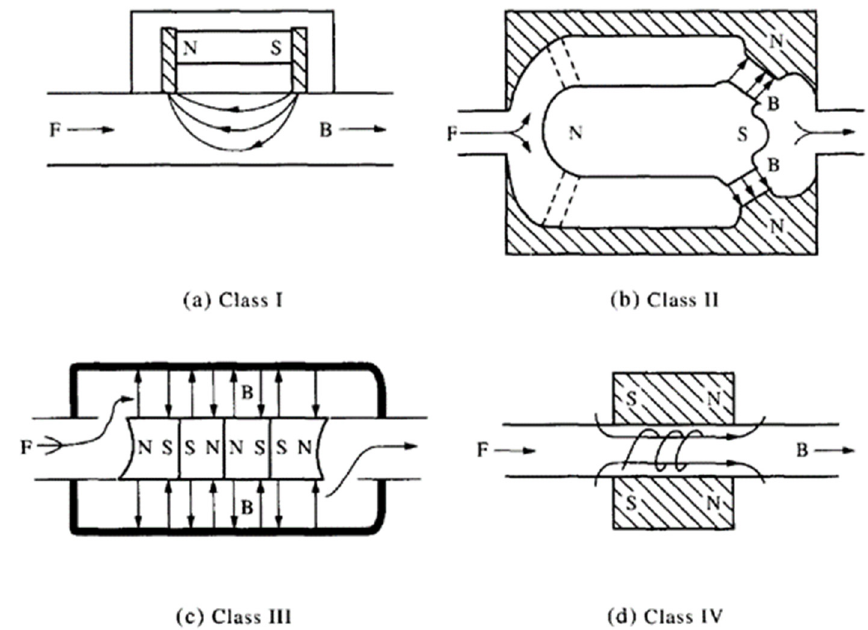
Figure 9. Configurations of magnetic assemblies [65].